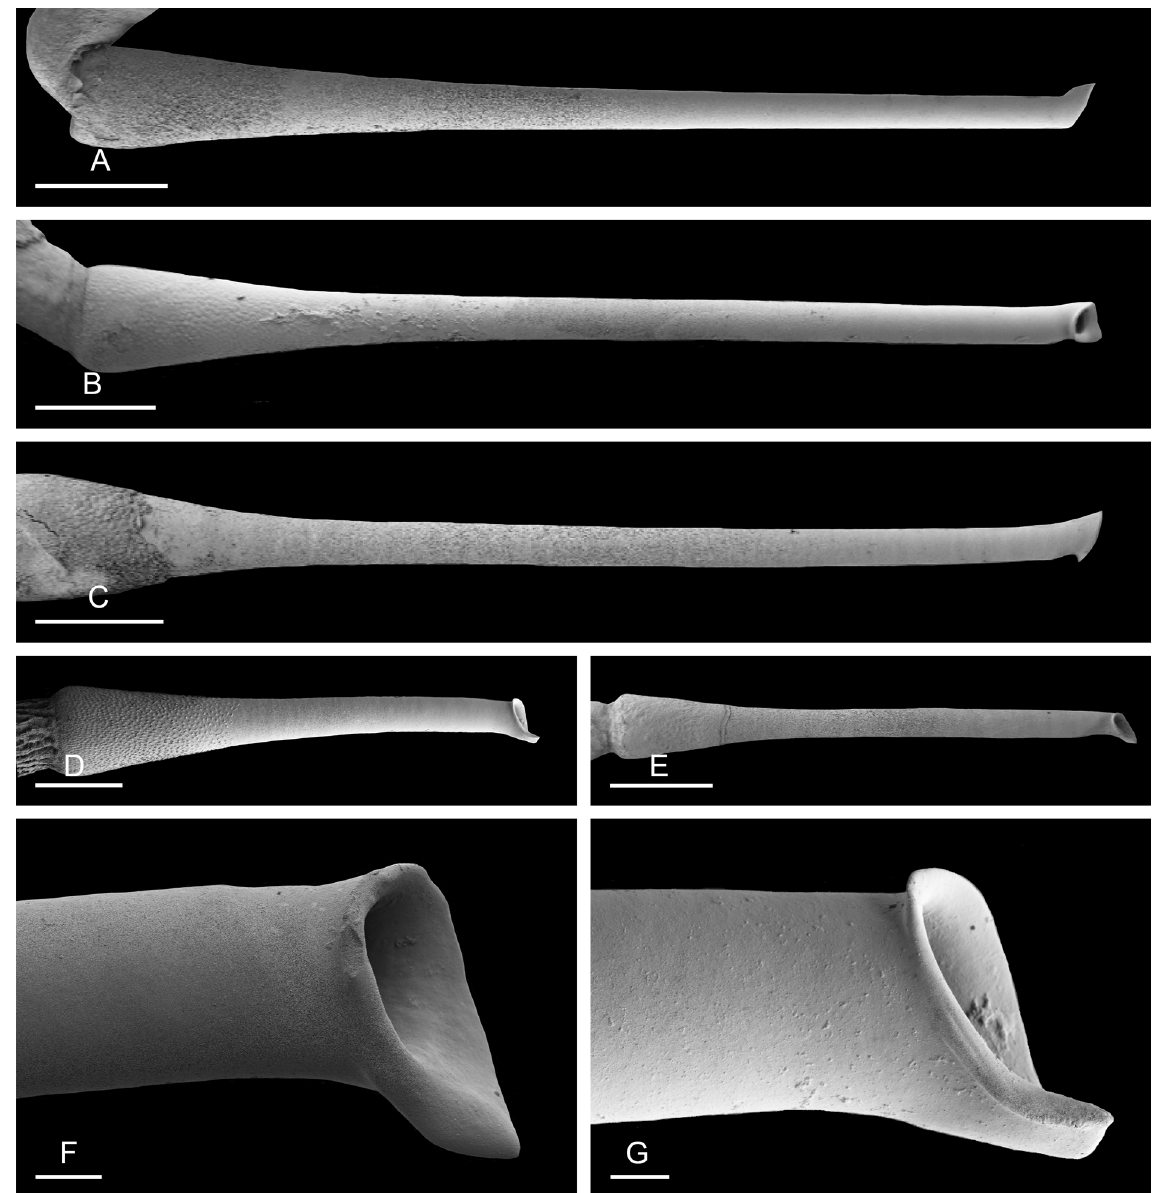
Fig. 18. Paromoionchis tumidus (Semper, 1880) comb. nov. unit #1, spine of accessory penial gland. A . Indonesia, Lombok [2950] (UMIZ 00131). B . Philippines, Bohol [3344] (PNM 041258). C .